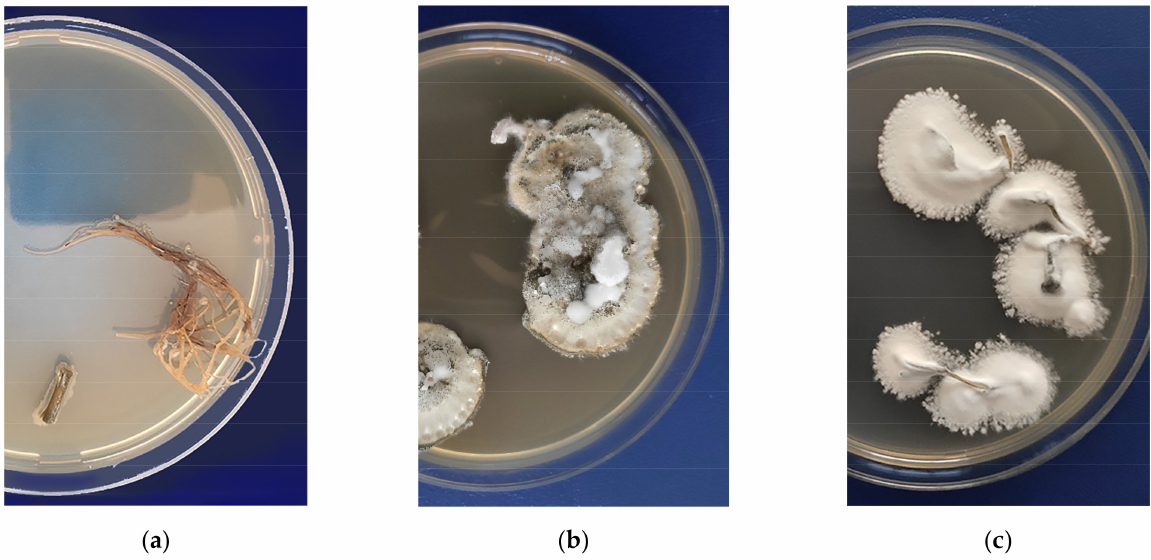
Figure 1. Fungal reisolation from the surface of sterilized roots on Sabouraud modified medium: ( a ) Control; ( b ) M. robertsii (strain P-72); ( c ) B. bassiana (strain